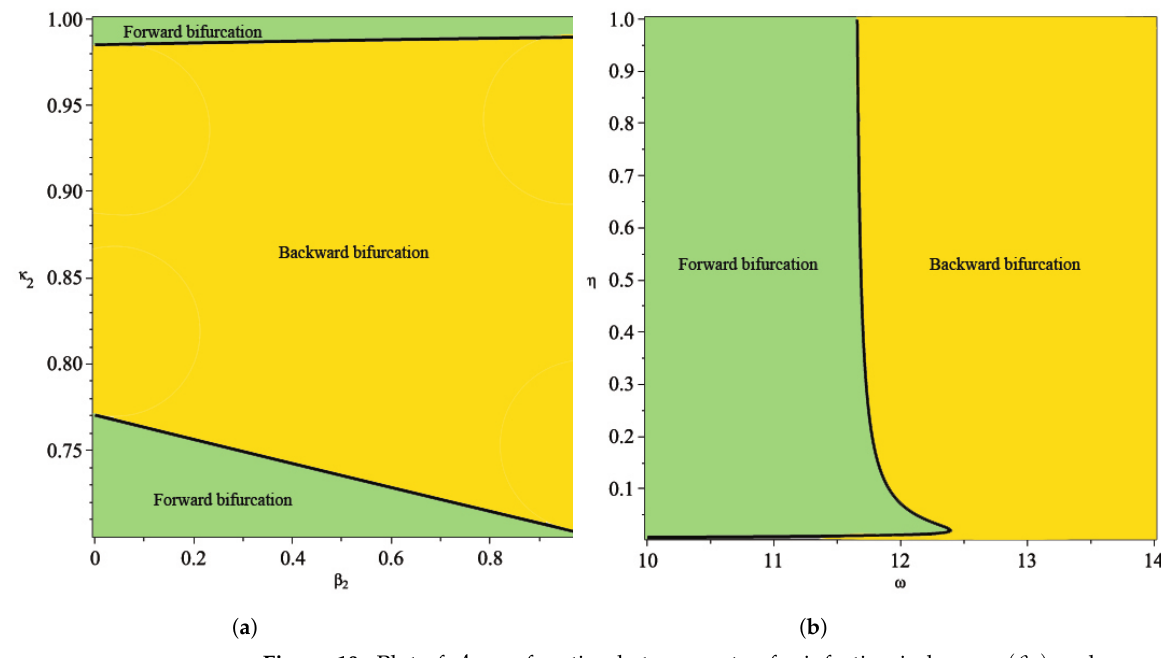
Figure 10. Plot of A as a function between rate of reinfection in human ( β 2 ) and recrudescence proportion ( κ 2 ) in ( a ) and between treatment saturation rate and rate of relapse ( η ) ( b